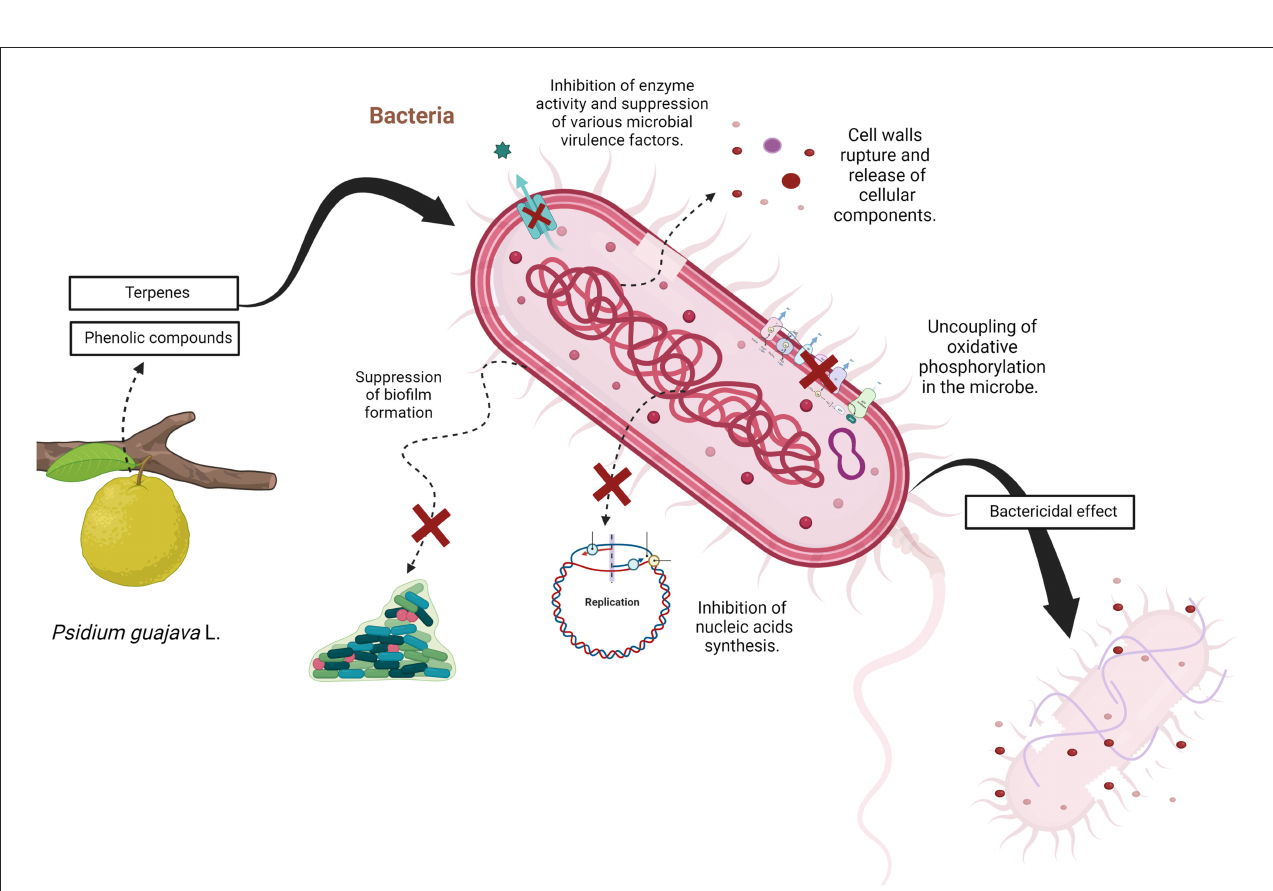
FIGURE4 The possible antibacterial mechanisms of action of Psidium guajava L., adapted and modified from Bankour et al.